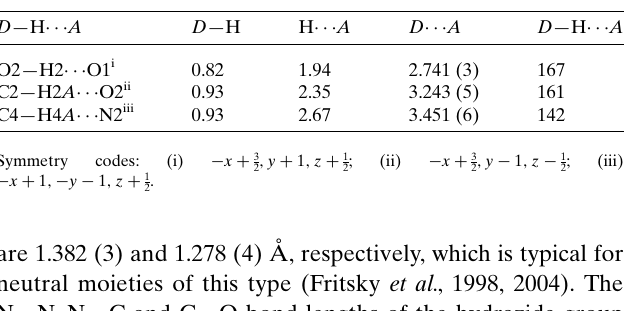
Table 1 Hydrogen-bond geometry (A˚ , (cid:3) ).